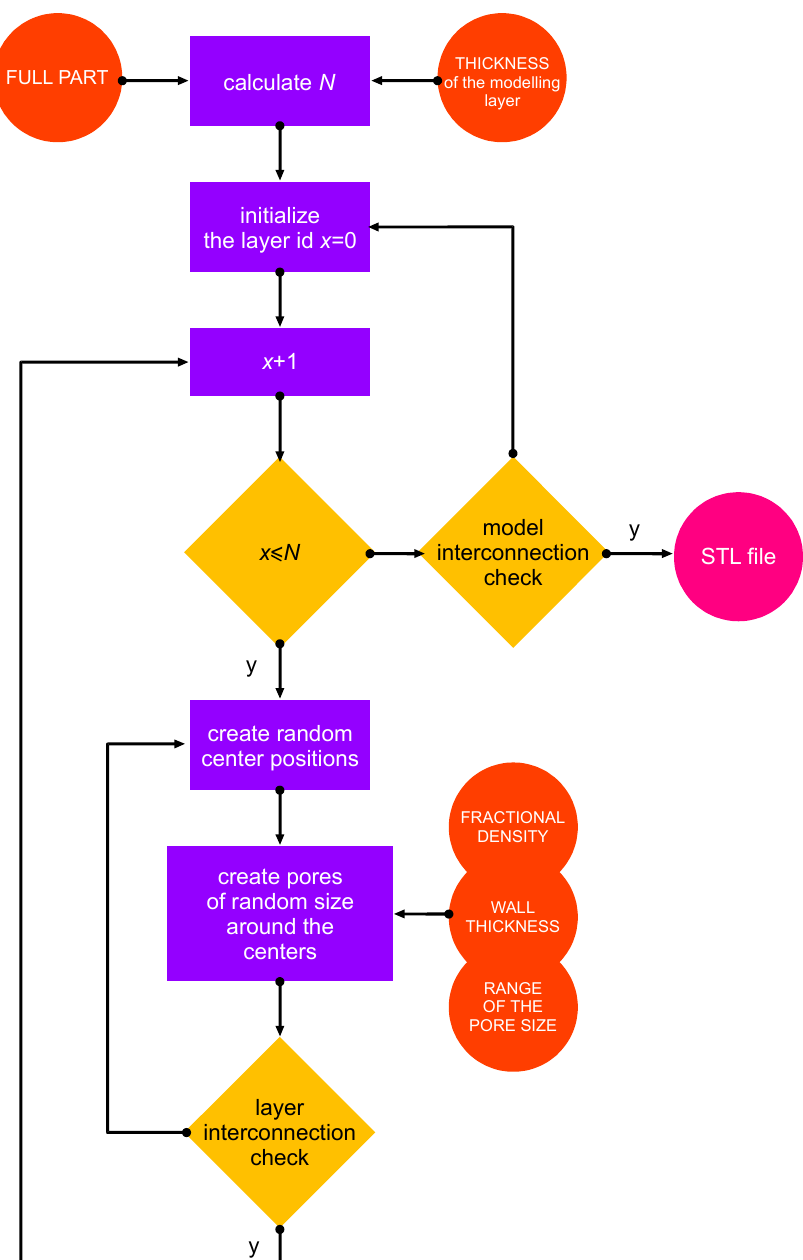
Figure 2. Flowchart of the algorithm to design a random foam structure.